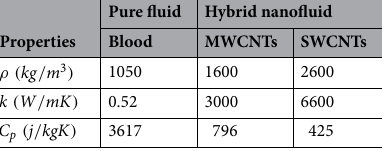
Table 2. The numerical properties of blood and CNTs